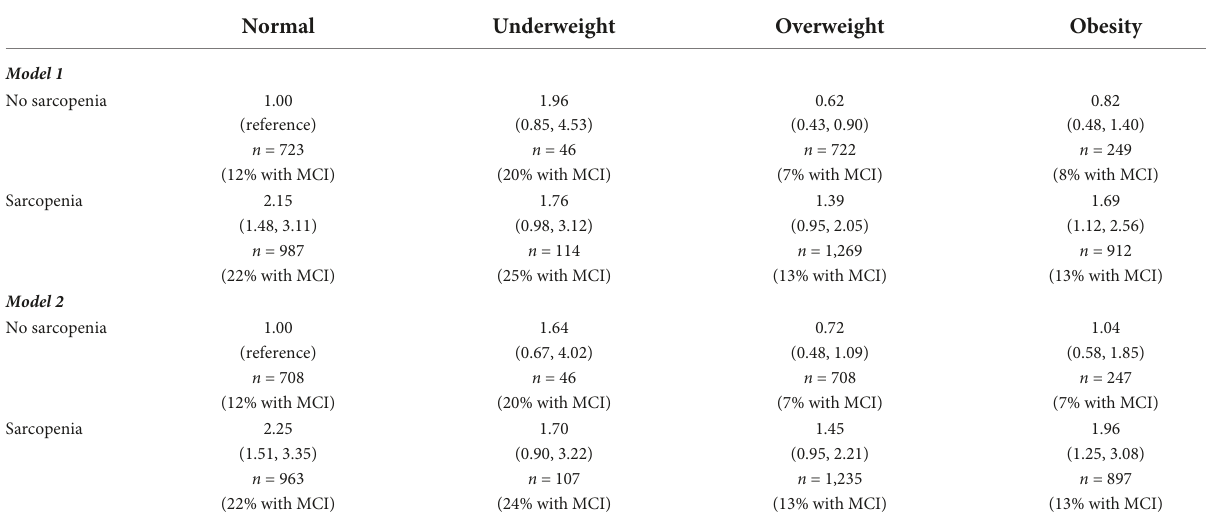
TABLE 5 Combined associations of body mass index and sarcopenia with mild cognitive impairment, where sarcopenia is defined using low grip strength reference values from Colombia. Body mass index Normal Underweight Overweight